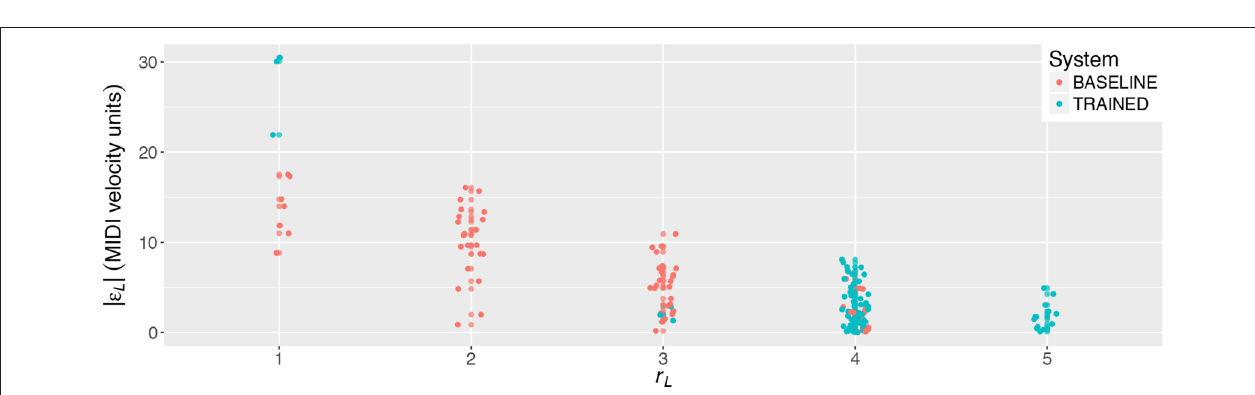
FIGURE 8 | Control over loudness rating ( r L ) and absolute loudness error ( | ε L | ) of all loudness and combined